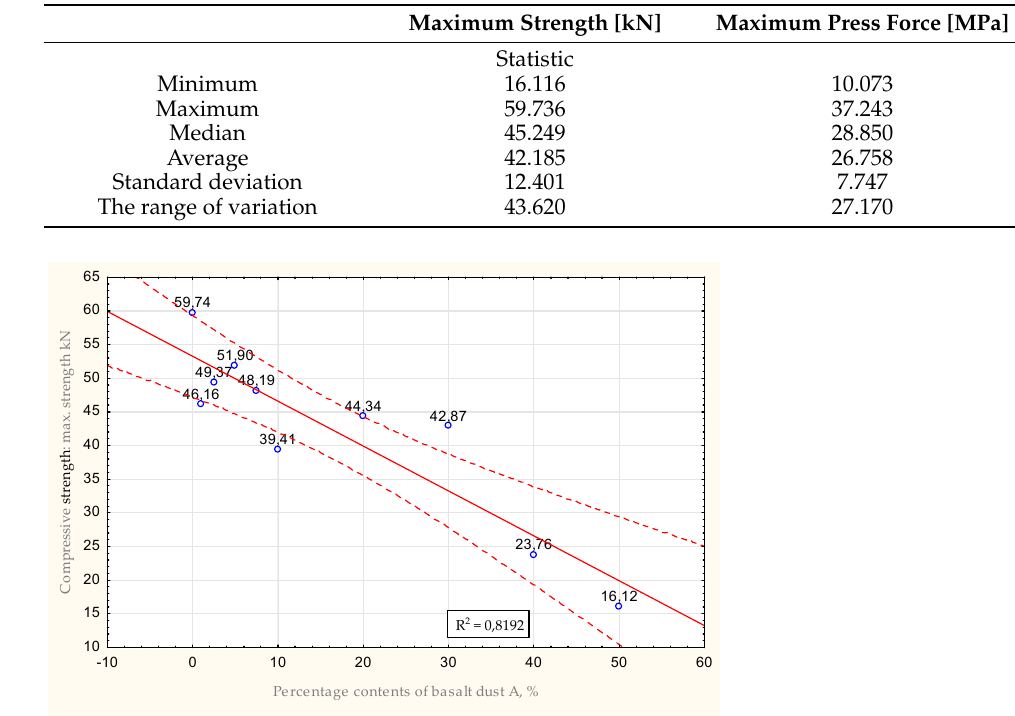
Table 14. Compressive strength tests for basalt dust A for all samples for water − mix ratio = 0.6.